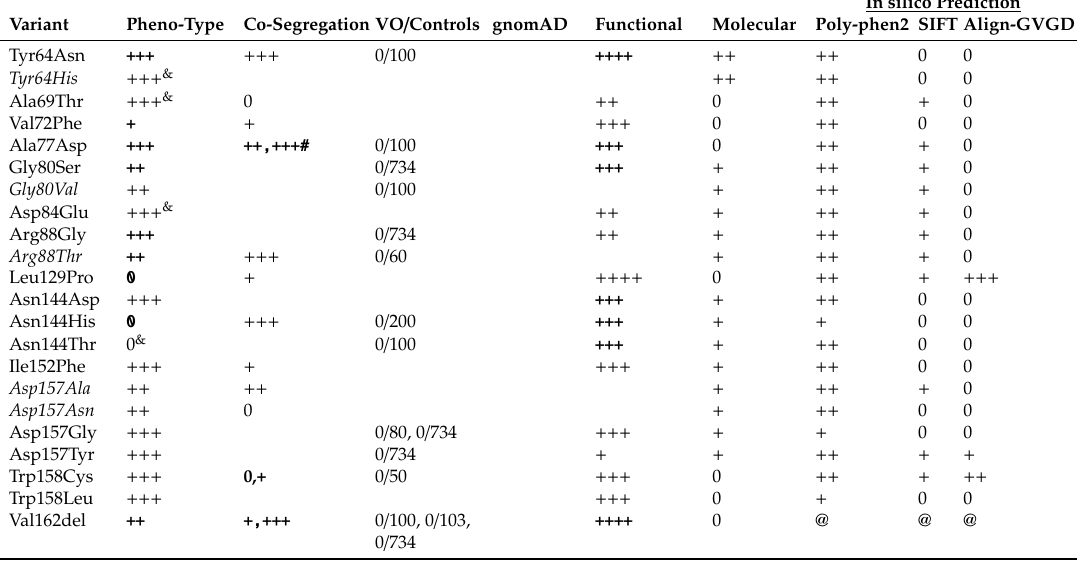
Table 4. Likelihood of pathogenicity derived from the reported data, and current databases and prediction